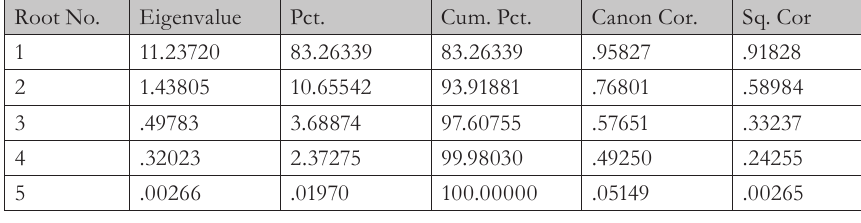
Tab. 1 – Eigenvalues and canonical correlations. Source: own research Root